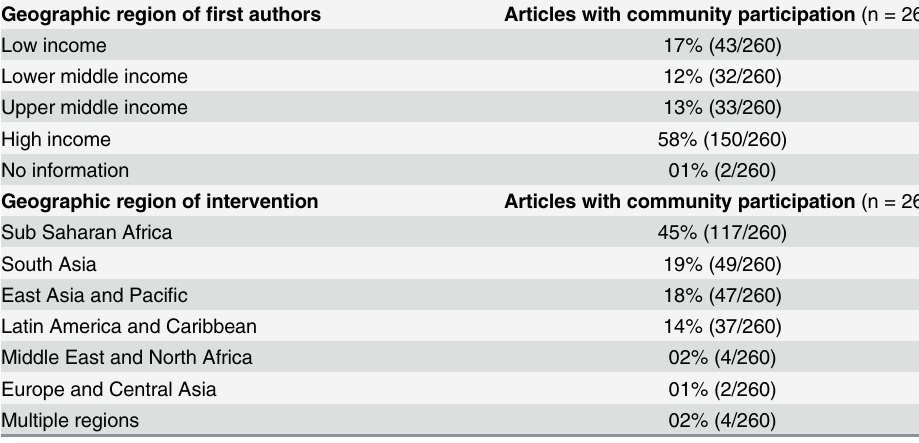
Table 3. Geographic region of first authors vs. region of intervention.